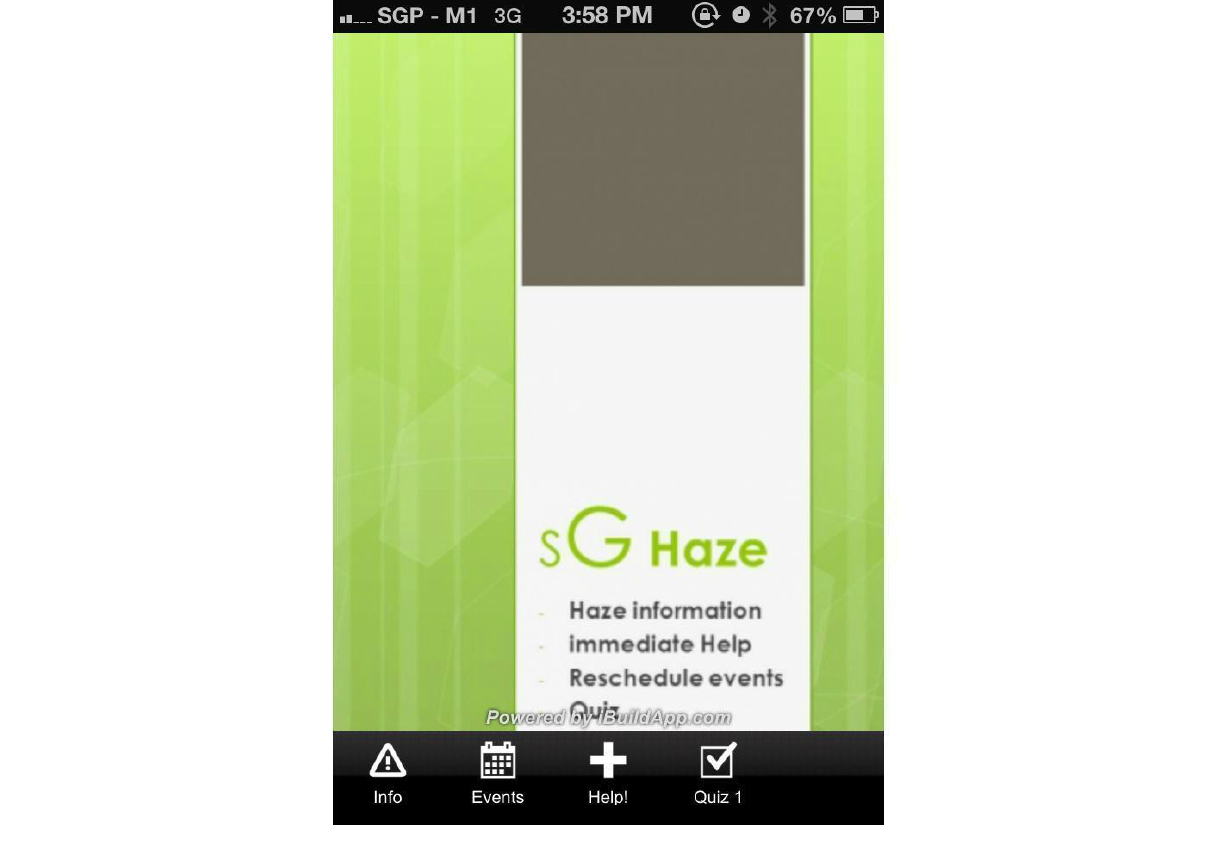
Figure 1. Overview of SgHaze smartphone application.